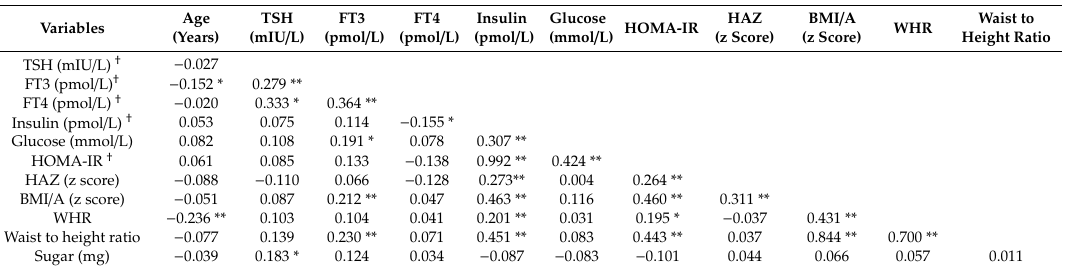
Table 5. Correlations between hormones and anthropometric data at baseline a . Variables